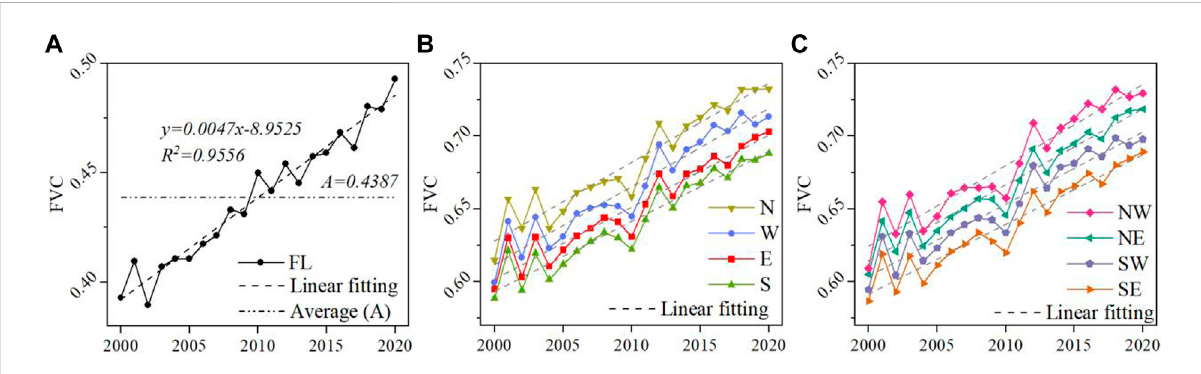
FIGURE 11 Distribution characteristicsofvegetationcoveragewithaspectintheupperreachesofGanjiangRiverBasinfrom2000to2020.FL,N,NE,E,SE, S,SW,W,andNWdenote fl atland,northslope,northeastslope,eastslope,southeastslope,southslope,southwestslope,westslope,andnorthwest slope,